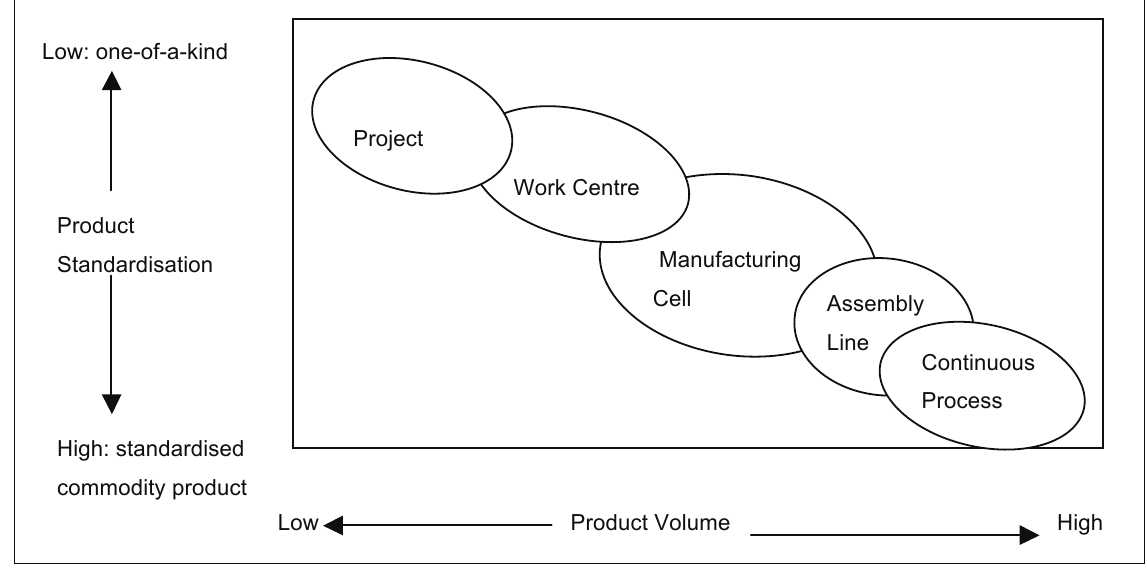
Figure 2: Product-process matrix: framework describing layout strategies Source: Jacobs et al (2009:207); Stavrulaki and Davis (2010:129)